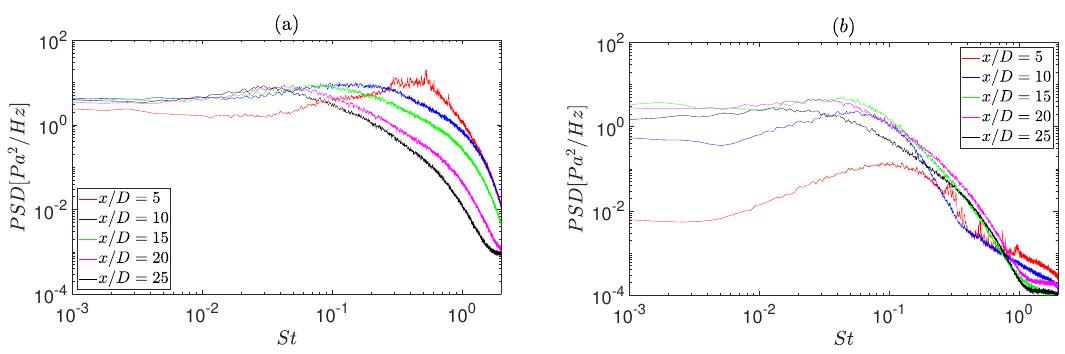
Figure 2. Axial evolution of the wall pressure autospectra at M j = 0.5: ( a ) H/D = 0.75; ( b ) H/D = 2.